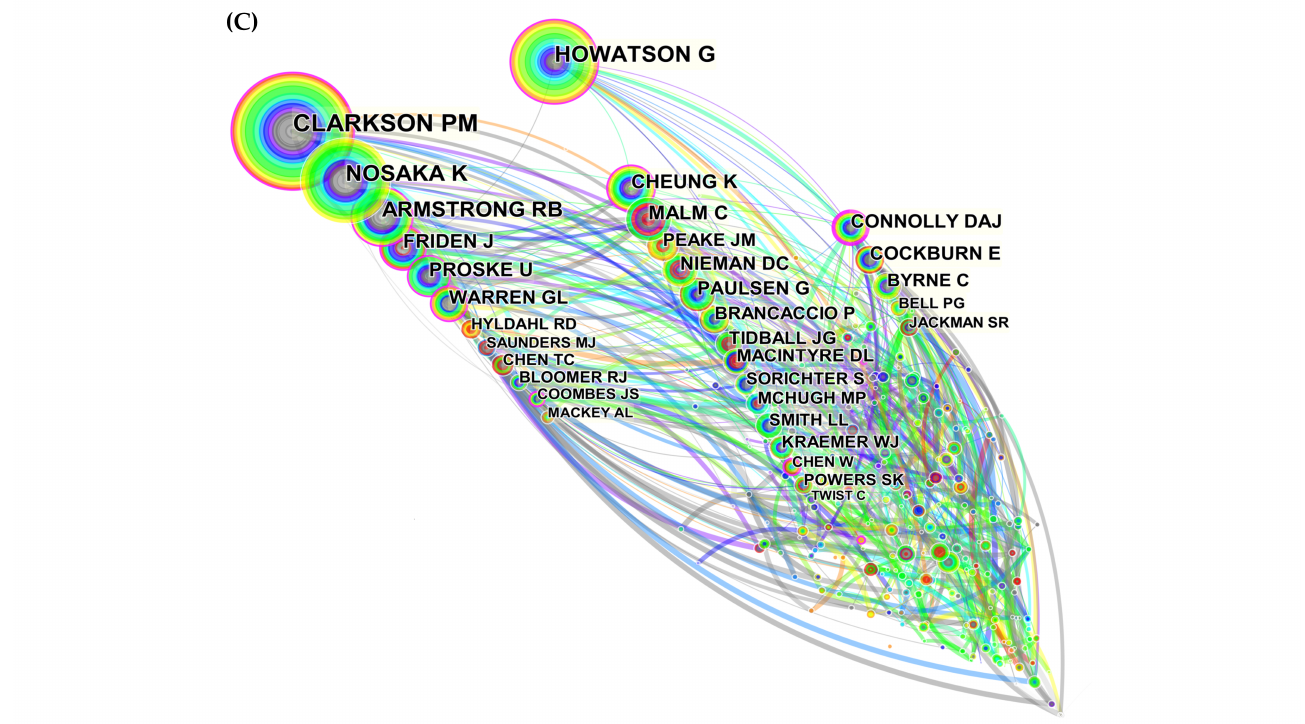
Figure 4. The top ten authors and co-cited authors and co-authorship networks. ( A ) Top ten authors; ( B ) top ten co-cited authors; and ( C ) co-authorship networks.